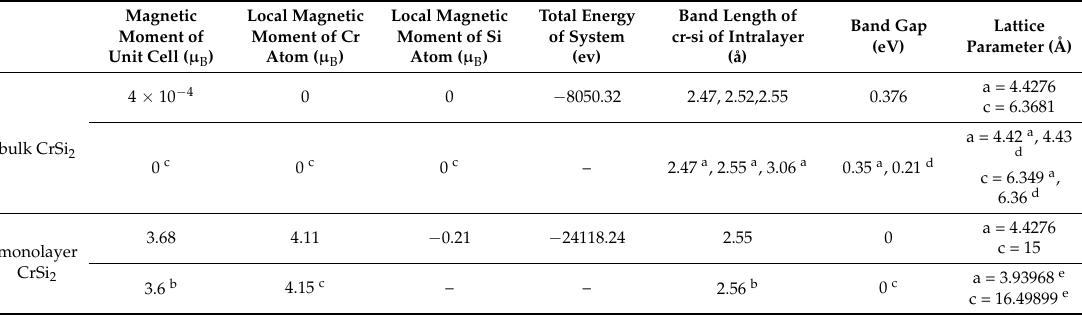
Table 1. Magnetic moment and structure of bulk and monolayer CrSi 2 .